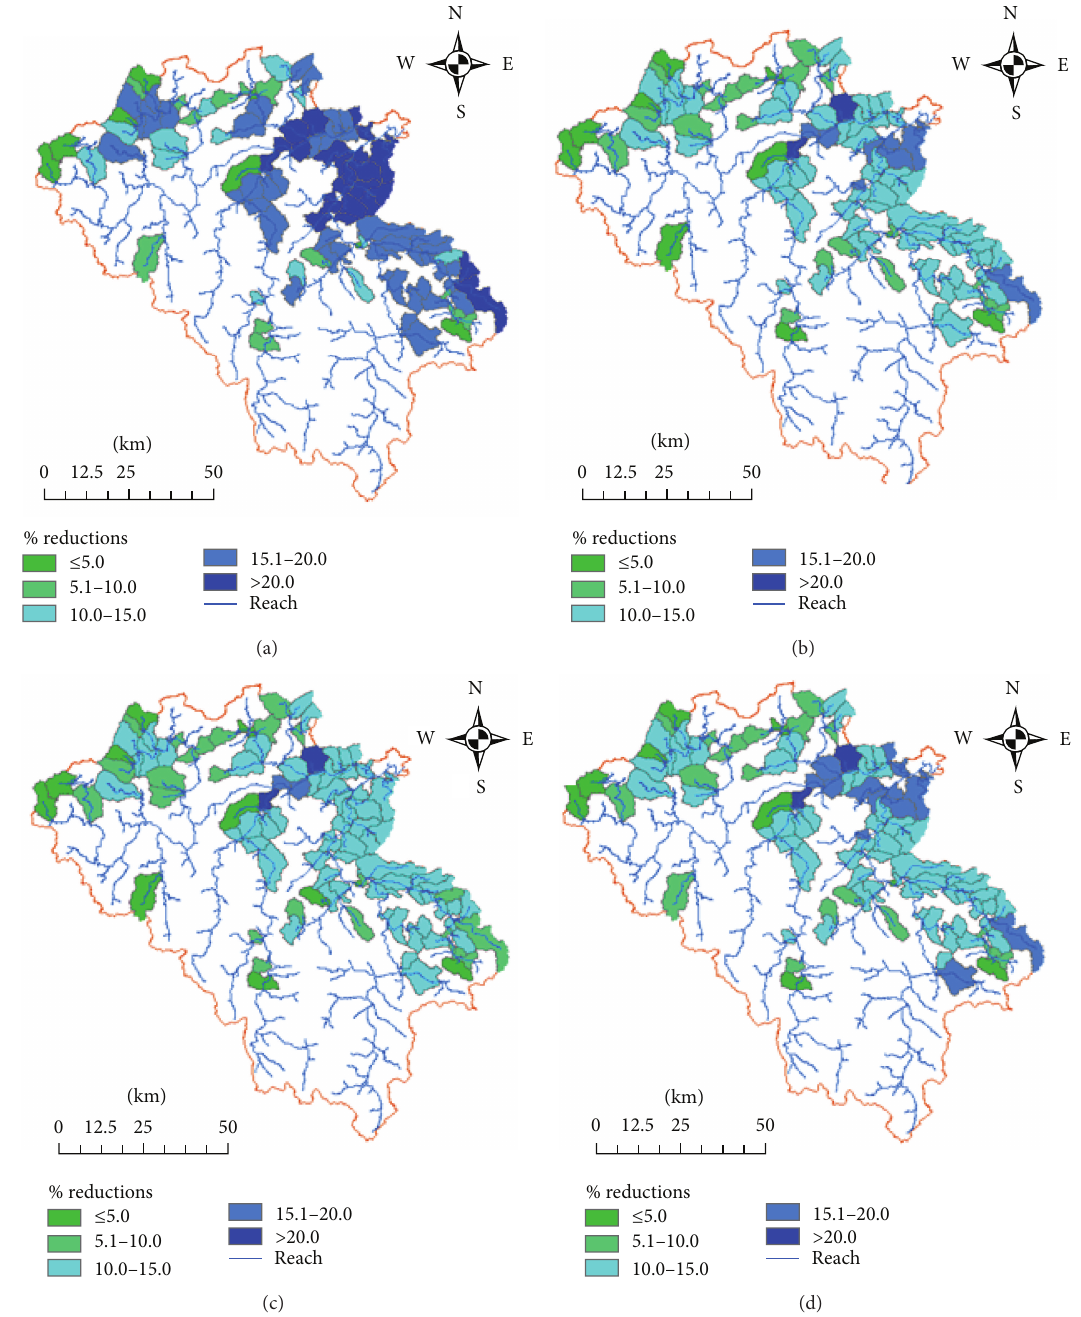
Figure 9: GHG emissions reduction with baseline (in percentage) from domestic wastewater treatment. (a) Scenario 1. (b) Scenario 2. (c) Scenario 3. (d) Scenario